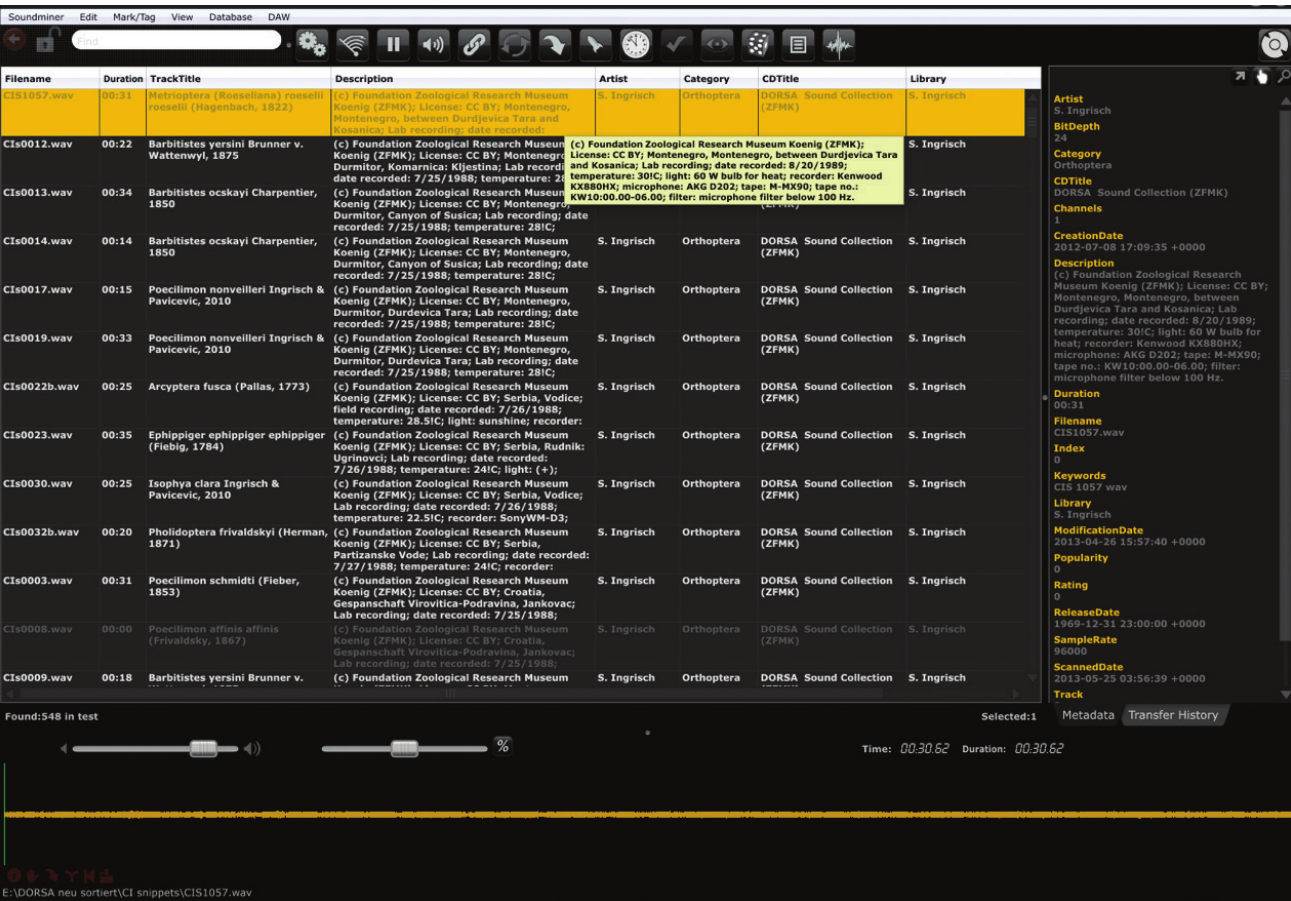
Fig. 3. Embedding metadata within sound files. Metadata were embedded within wav and mp3 fields directly from the SYSTAX data- base using Soundminer software (http://store.soundminer.com/). Metadata are visible within most mp3-players, displaying the species name as “TrackTitle” and the recordist as “Artist” (Courtesy: S.